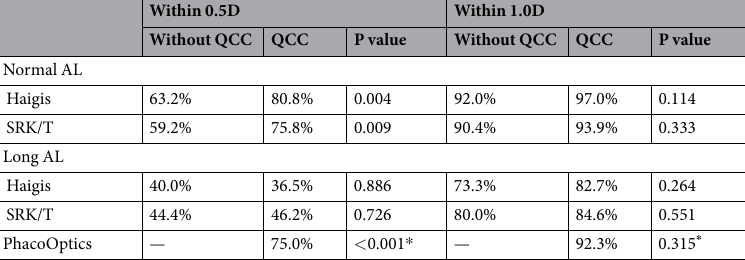
Within 0.5D Within 1.0D